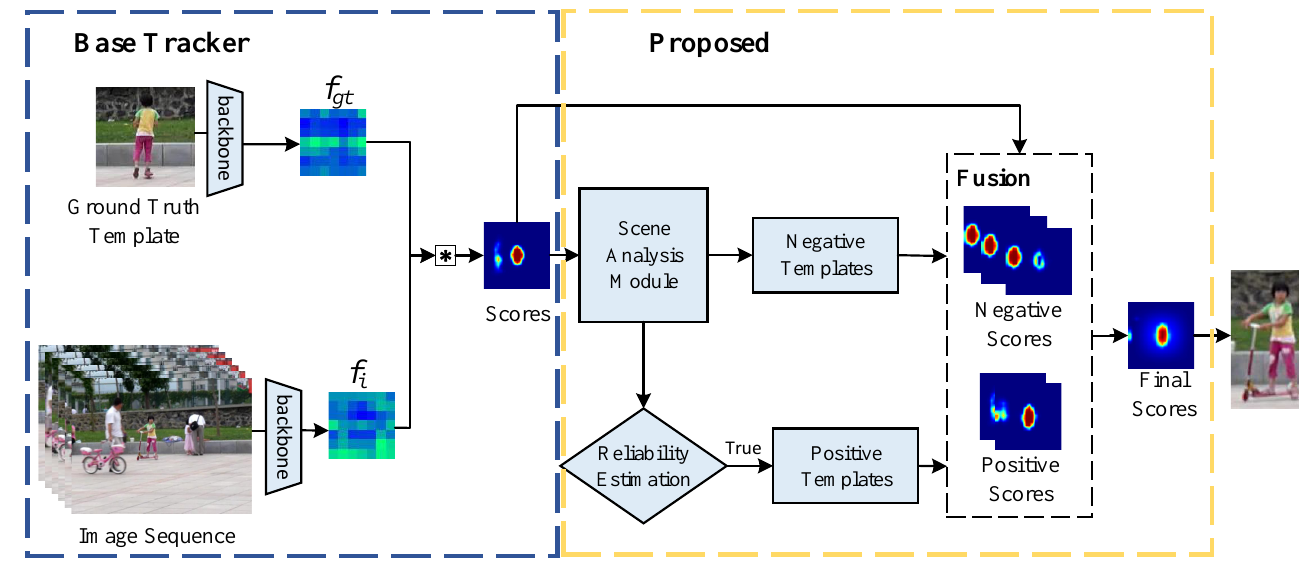
Figure 2. The framework of our approach. The base tracker part is the common framework of Siamese-based trackers. For each frame, the features of the template image and the search image are extracted using a shared-weight network. Then, a score map is generated by the cross-correlation of the two features. To further exploit the information from the score map, we take the scores as a whole and process them using our scene analysis module. The objects with highly similar responses are collected as negative templates. Next, we estimate the tracking reliability leveraging the outcomes of the SAM and collect confident tracking results as positive templates. Finally, the scores of the ground truth, negative, and positive are fused and the tracking box is regressed from the fused score